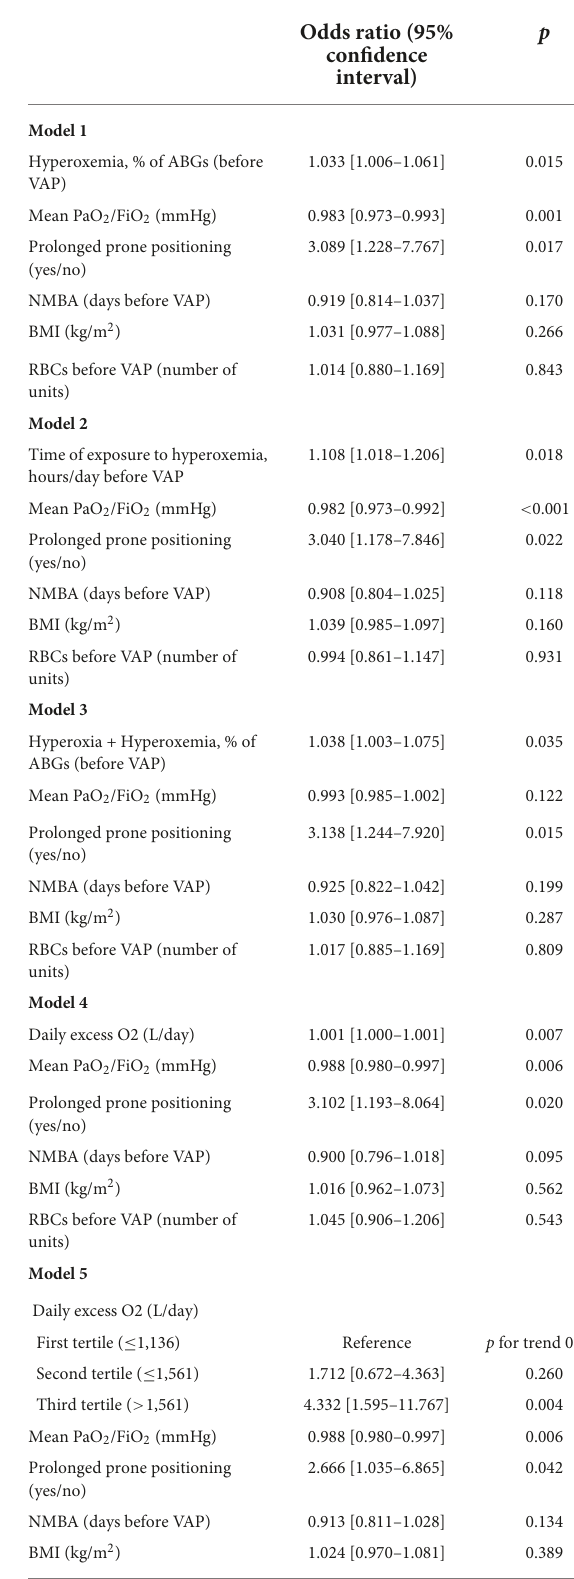
TABLE 6 Binomial logistic regression models for the association between hyperoxemia and